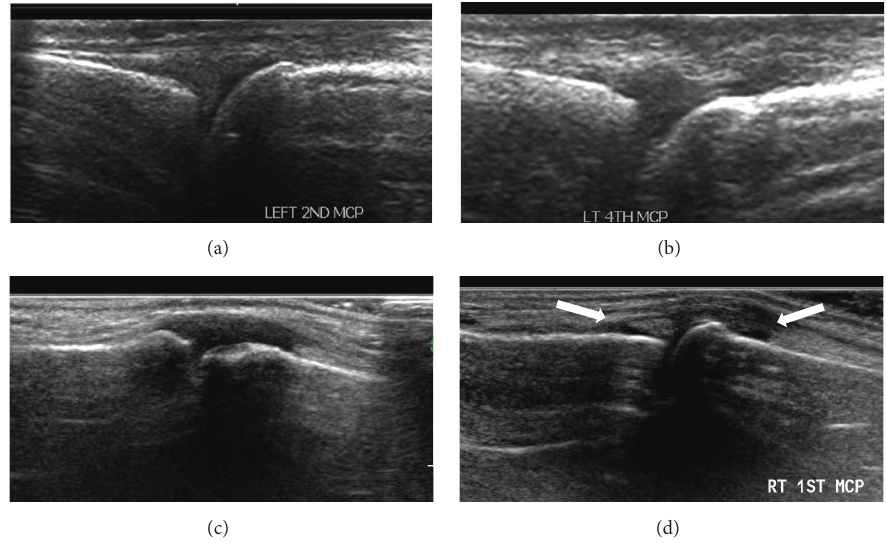
Figure 1: (a–d) Grading of synovial thickening is depicted; (a) Grade 0, (b) Grade 1, (c) Grade 2, and (d) Grade 3. Arrows indicate extension of synovial thickening to both metadiaphyses.